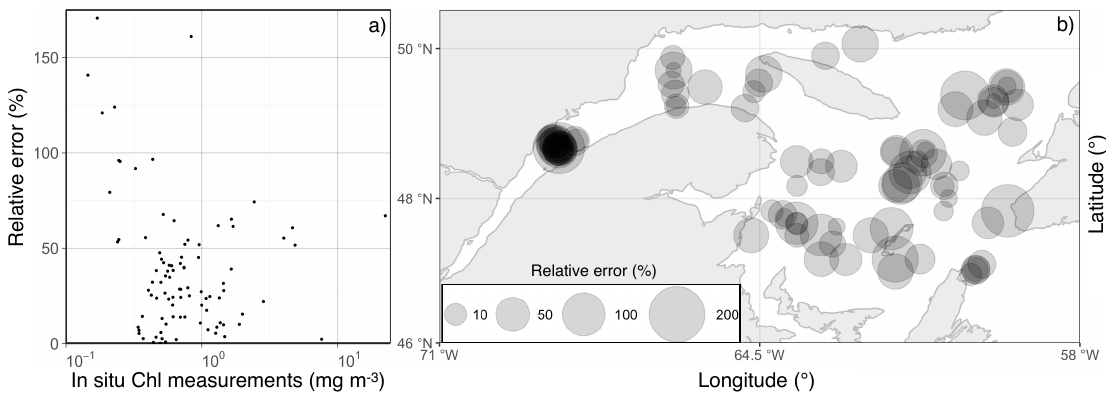
Figure 5. Relative error as a function of ( a ) Chl concentration and ( b ) spatial